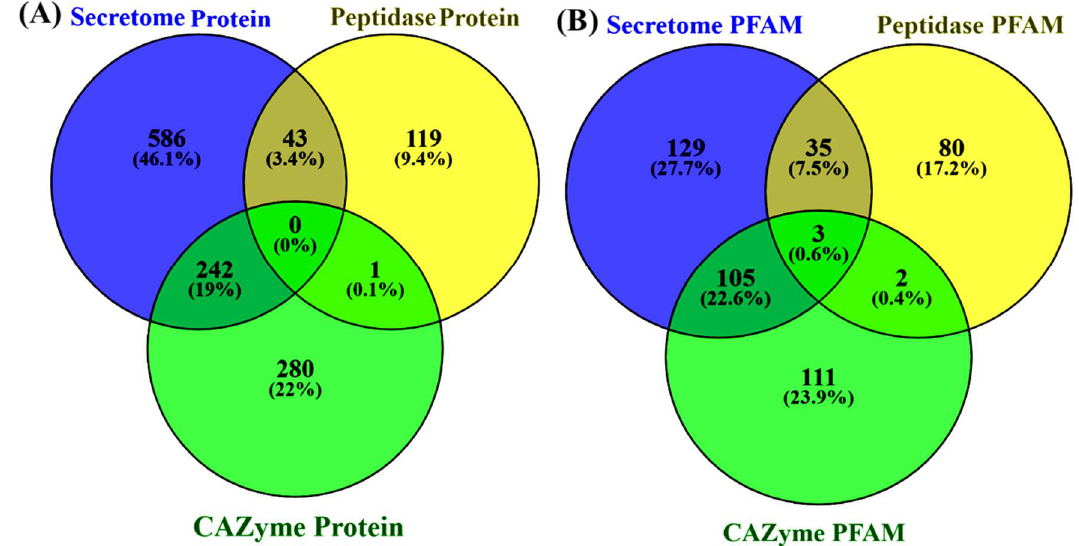
Figure 5. The identified proteins were classified against secretome, MEROPS (peptidase), CAZymes, and PFAM database. ( A ) The protein sequences shared and uniquely classified into secretome, MEROPS, and CAZymes. ( B ) The protein sequences classified against each database (secretome, MEROPS, CAZymes) mapped to distinct PFAM, thus depicting the shared and uniquely PFAM in mapped sequences.